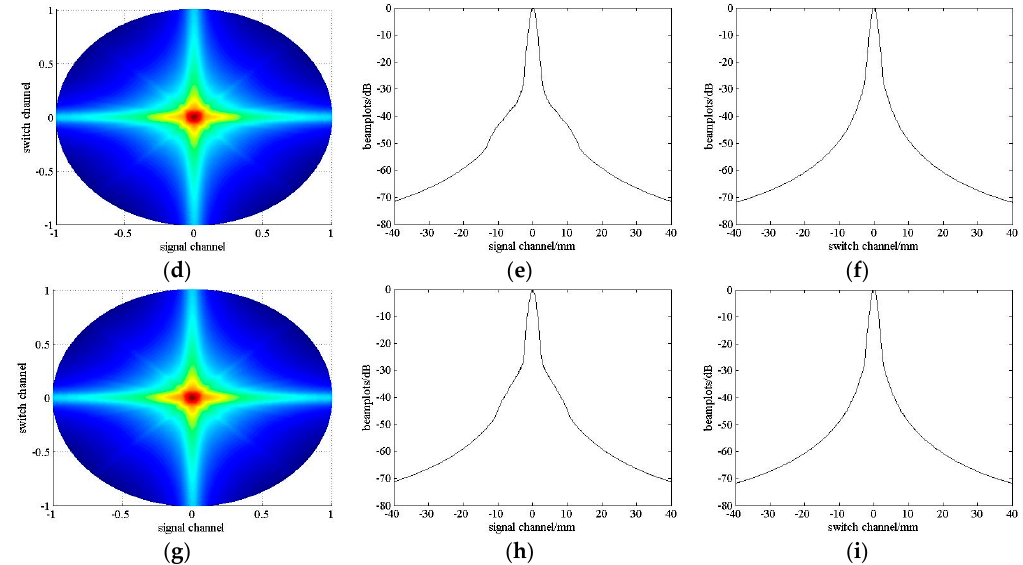
Figure 6. The beamplots of a 32 × 32 SRCA with K = 3 for scheme No. 5 a – c , scheme No. 7 d – f and scheme No. 9 g – i in switch channel direction and signal channel direction. Table 2. The measured parameters of a 32 × 32 FSA and scheme No. 5, 7 and 9 for a 32 × 32 SRCA with K = 3.